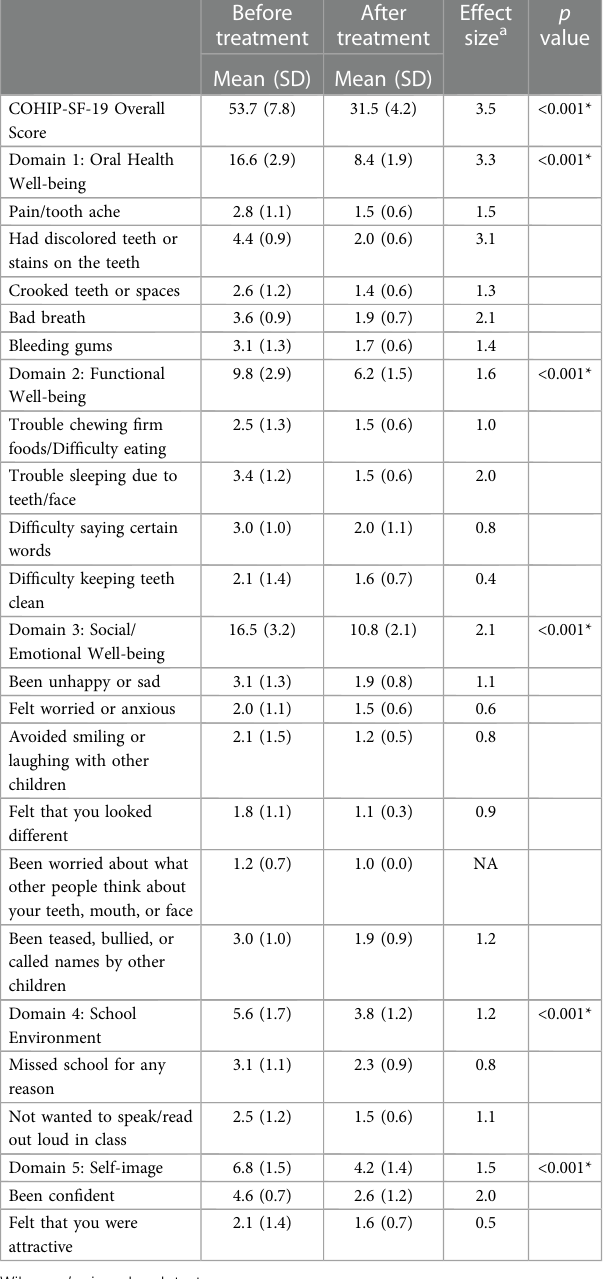
TABLE 5 Descriptive statistics of the sum of scores before and after dental treatment of the child oral health impact pro fi le-short form 19 (COHIP- SF-19) ( n